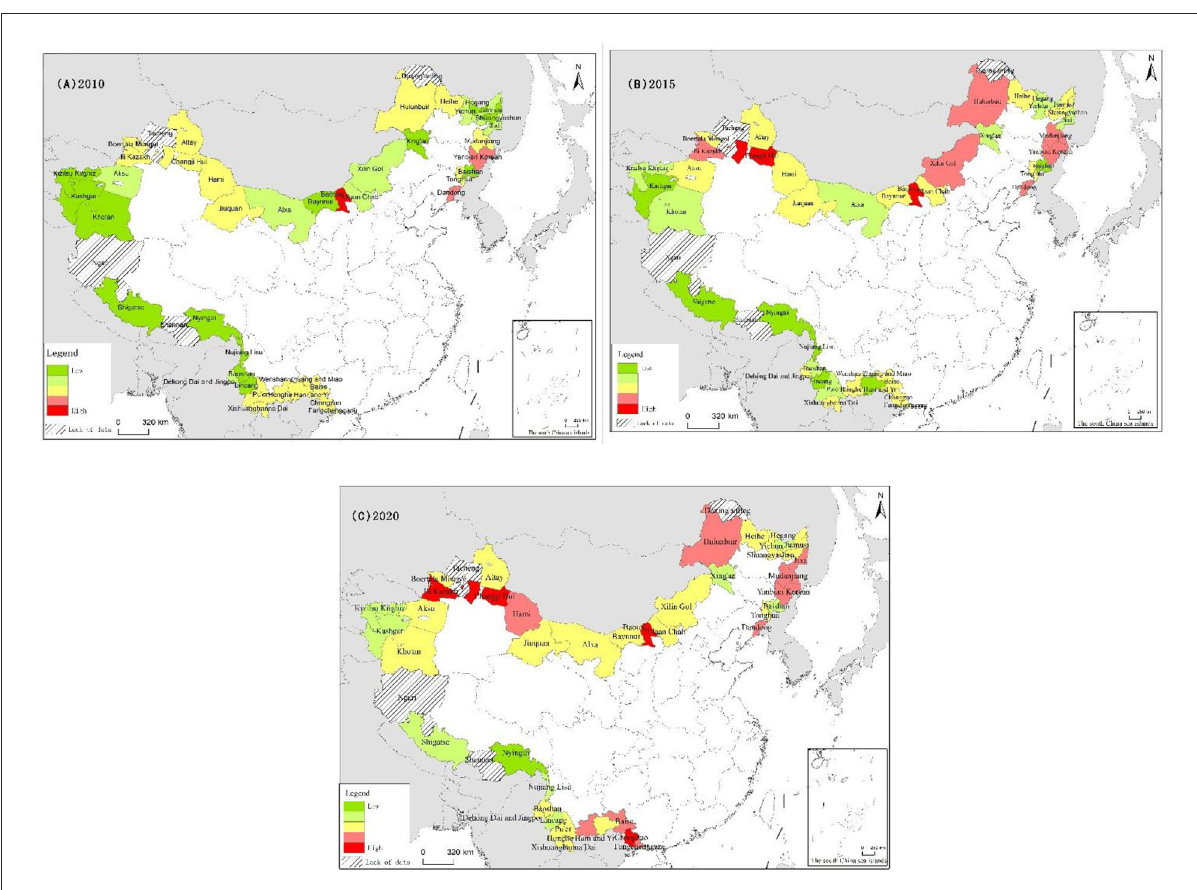
FIGURE2 Spatial pattern of resilience for border cities in China in 2010 (A) , 2015 (B) , and 2020 (C)